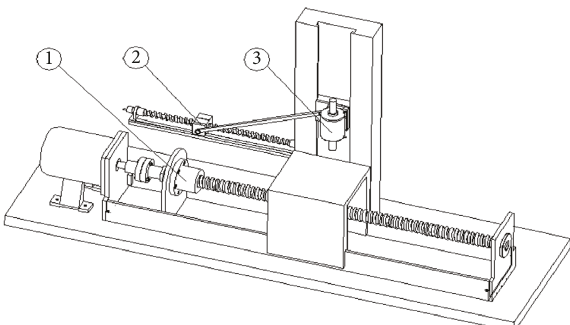
Figure 1: 3D model of the mechanical structure of the test